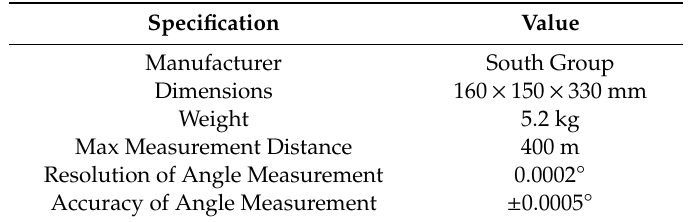
Table 3. The specifications of the NTS-322R4 total station (Reflectorless).